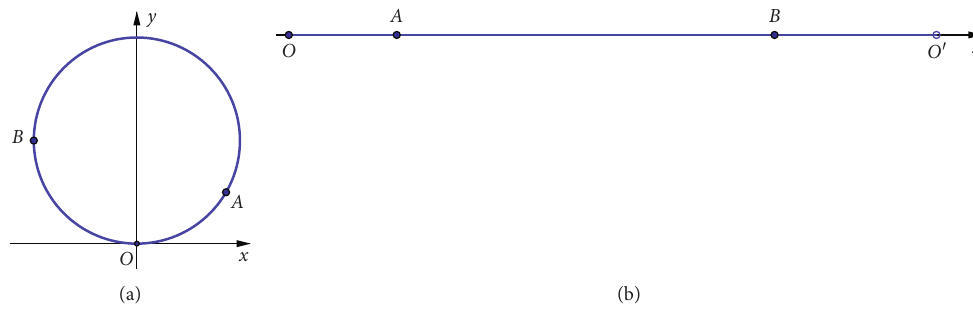
Figure 1: Circular market and its linearization. (a) Diagram of the circular market. (b) Linearization of the